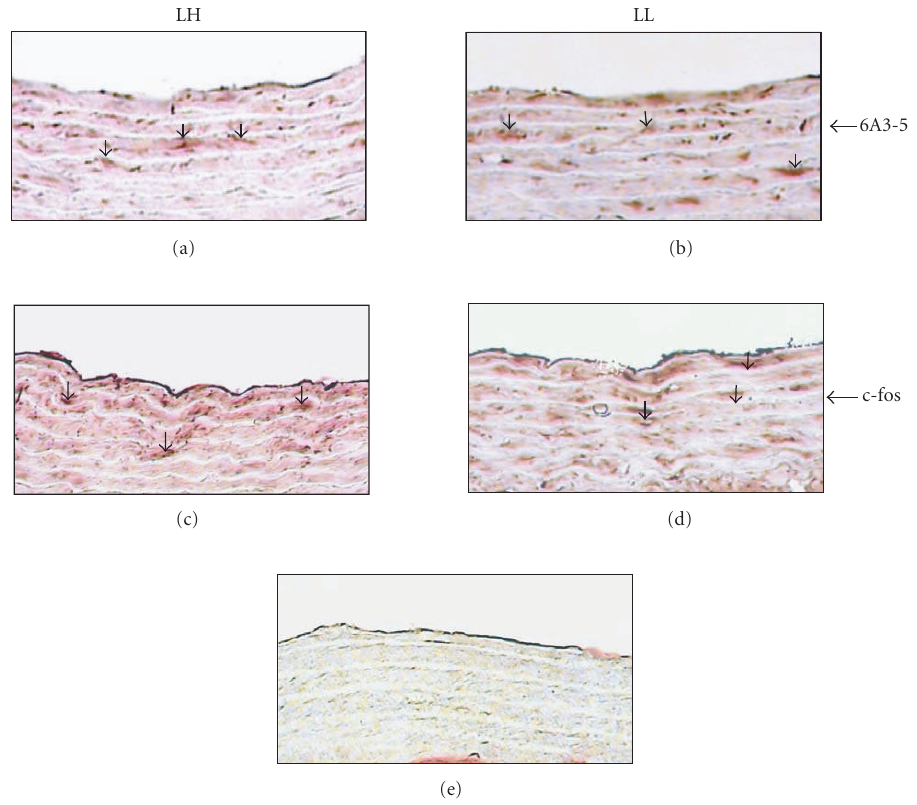
Figure 9: Localization of 6A3-5/Osa2 in aortas from LH and LL rats . (a) 6A3-5/Osa2 labelling is observed in SMC of the inner media from AngII-perfused LH rats (X40). (b) 6A3-5/Osa2 labelling is observed in SMC of the inner media from AngII-perfused LL rats. (c) c-fos antibody showed a similar localization to 6A3-5/Osa2 in LH rats. (d) c-fos antibody showed a similar localization to 6A3-5/Osa2 in LL rats. (e) Negative control showed no labelling. Similar localization and labelling was observed for 6A3-5/Osa2 for all tested aortas (data not